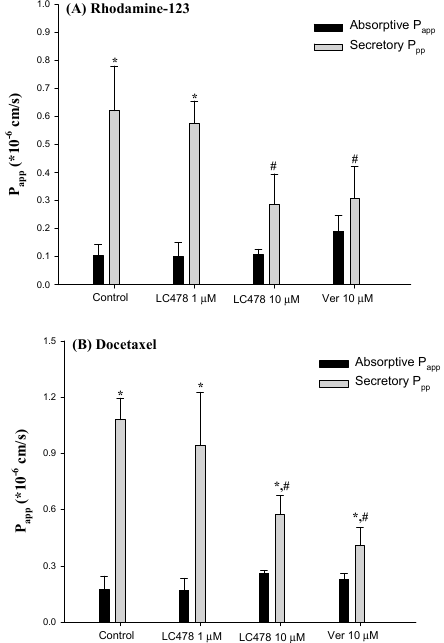
Figure 5. Absorptive P app ( ■ ) and secretory P app ( ■ ) of Rhodamine-123 ( A ) or docetaxel ( B ) across the rat small intestine with various concentrations of verapamil or LC478. Vertical bar represents SD. * Significantly different ( p < 0.05) from absorptive (M to S) group. # Significantly different ( p < 0.05) from control group.